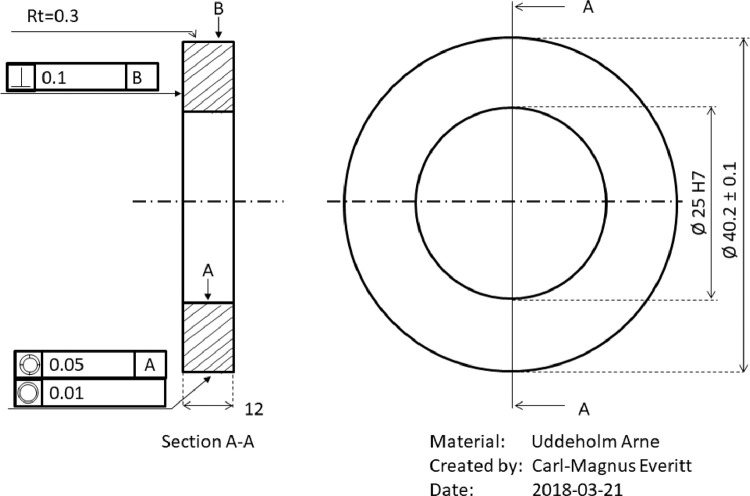
The indent-disc.